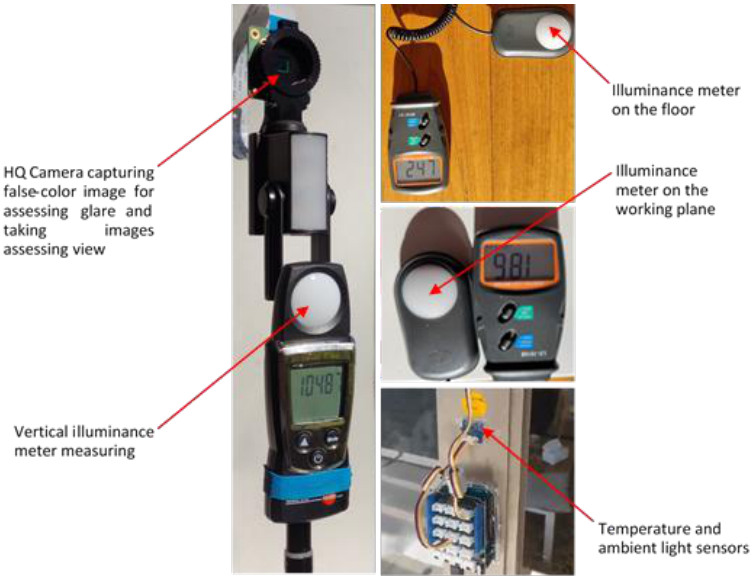
Figure 10. Field experiment validation of the simulation results.